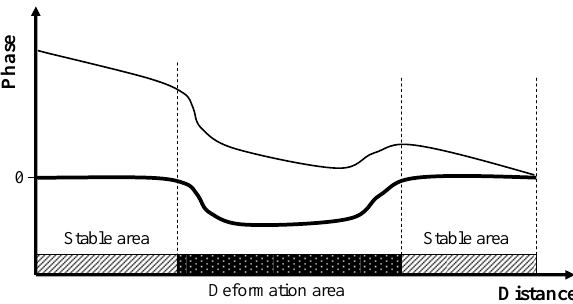
Fig. 4. Scheme of the atmospheric and orbital phase de-trending achieved by zeroing the phase over the stable areas. The original phase profile, affected by a trend, is depicted with a thin line, while the de-trended one is shown in bold.